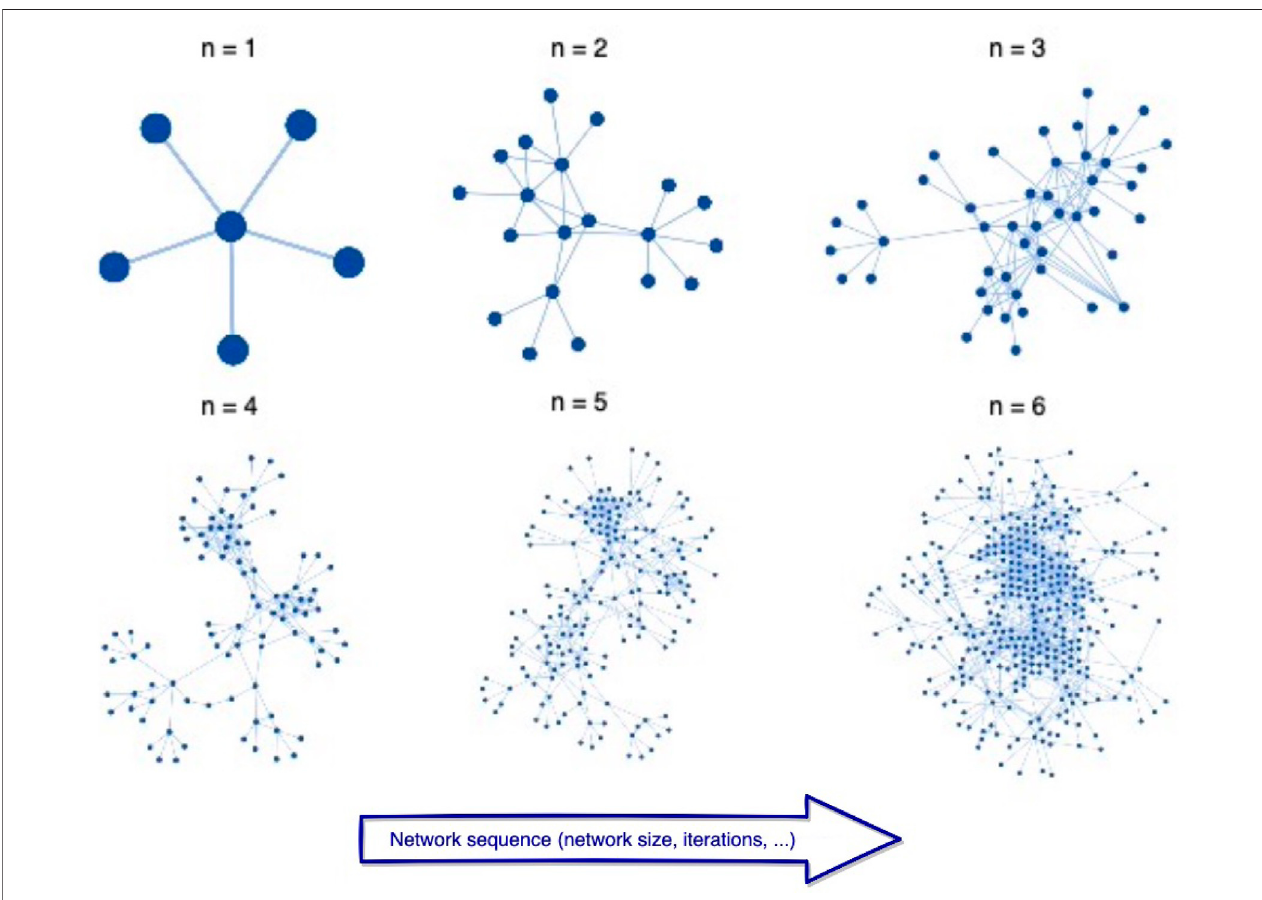
FIGURE 2 | Sub-network growth process. Starting ( n = 1) from a single node (site), at each iteration n , a representative sample — consisting of the top fi ve nodes which present the highest audience overlap with the analyzed website — is added per each new node included in the sub-network. The nodes are linked to each other if there isarelationship based on audience overlap. The process stops after sixiterations, according tothe “ six-degree separation ” phenomenon,whichstates thatnearly everyone is only six steps away.